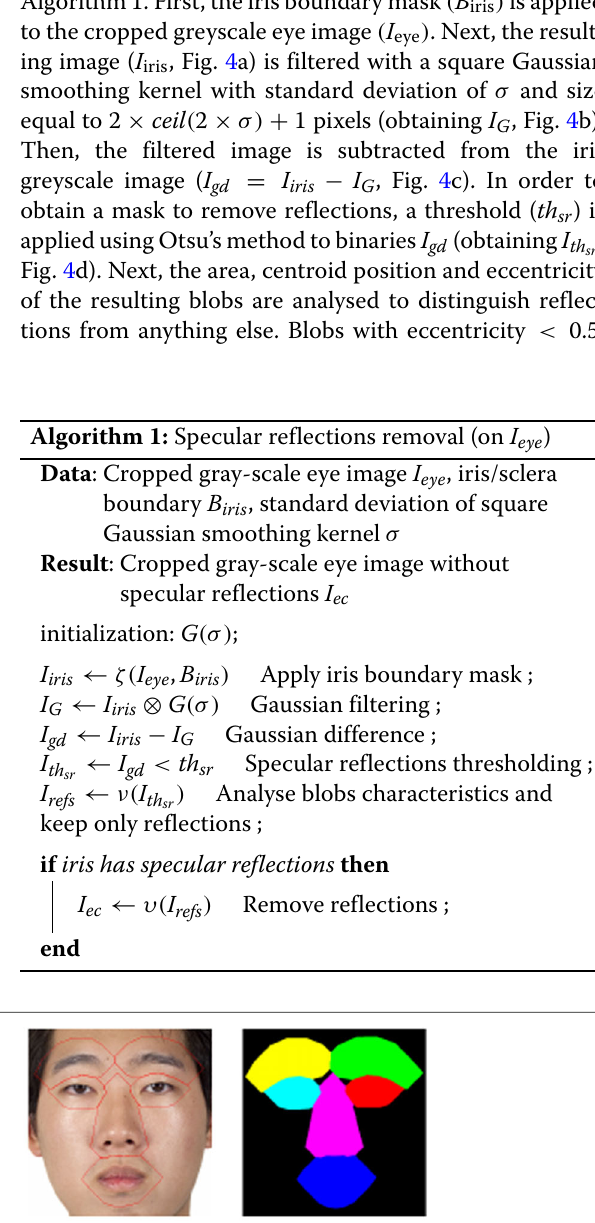
Algorithm 1. First, the iris boundary mask ( B iris ) is applied